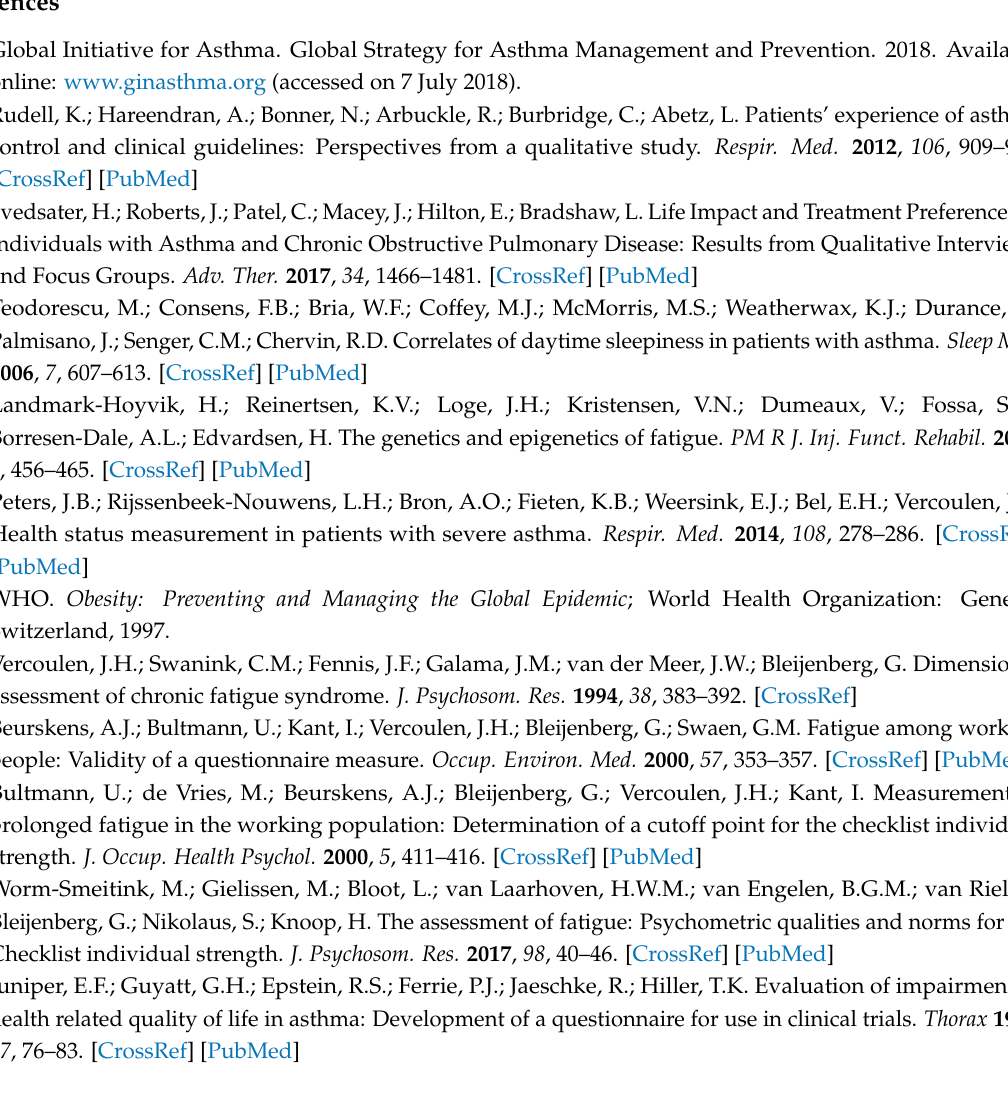
Table S1: Spearman rank correlation coefficients of demographical, health status and disease-specific characteristics with fatigue in asthmatic patients ( n = 733), Table S2: Multiple stepwise regression analysis of the significant variables associated with CIS-Fatigue; Table S3: Spearman rank correlation coefficients of demographical, health status and disease-specific characteristics with disease-specific QoL in asthmatic patients ( n = 653), Table S4: Multiple stepwise regression analysis of the significant variables associated with